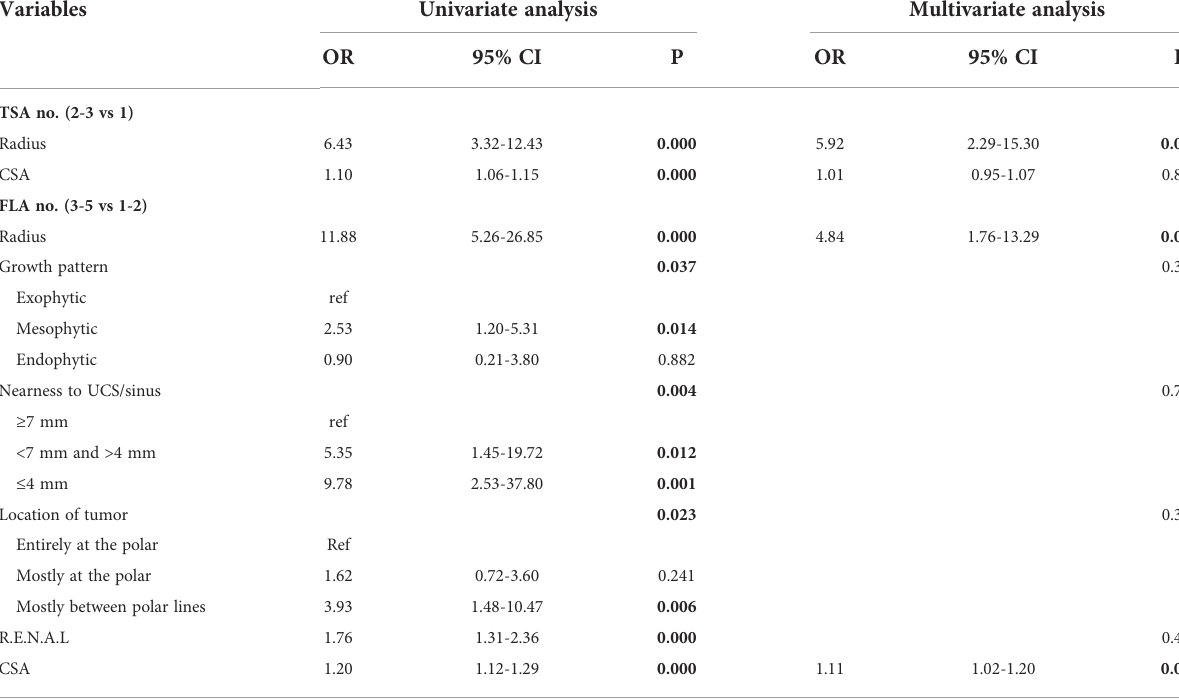
TABLE 5 Logistic regression analysis on the numbers of target segmental arteries and feeding lobar